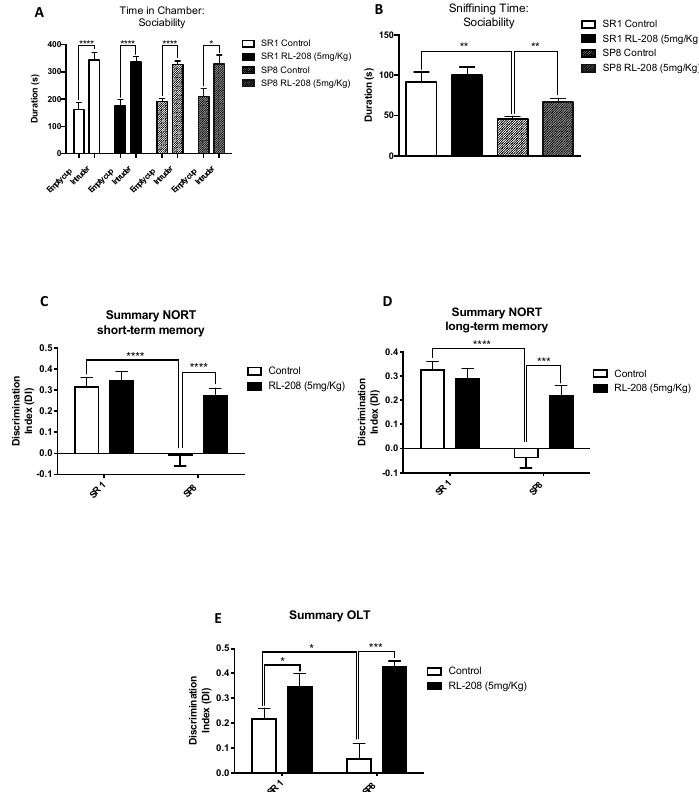
Figure 2. Results of Three Chamber Test (TCT), Object Location Test (OLT), and Novel Object Recognition Test (NORT) in male mice at 24-weeks-old SR1 and SP8 Ct mice groups and SR1 and SP8 treated with RL-208 (5 mg / Kg) mice groups. For TCT: Time spent in the chamber ( A ) and sni ffi ng time: sociability with the intruder animal ( B ). For NORT: Summary of Discrimination Index (DI) from short-term memory ( C ), and summary of DI from long-term memory ( D ). For OLT: Summary of DI ( E ). Values represented are mean ± Standard error of the mean (SEM); n = 41 (SR1 Ct n = 11; SP8 Ct n = 8; SR1 RL-208 n = 10; SP8 RL-208 n = 12). *p<0.05; **p<0.01; ***p<0.001; ****p<0.0001.